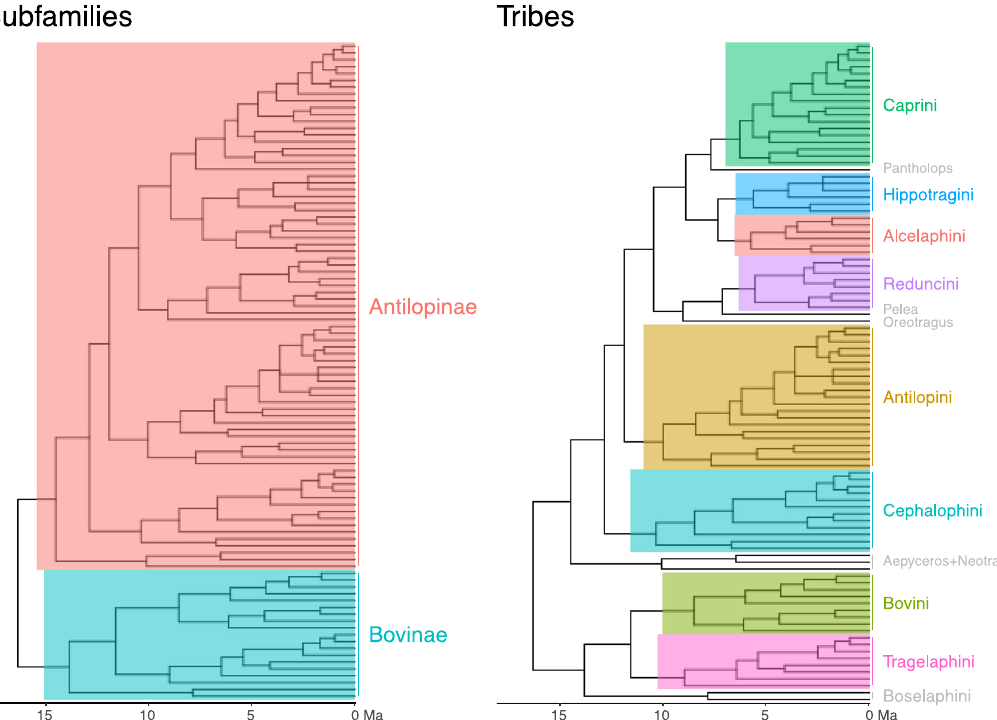
Fig. 1 Dated phylogeny of Bovidae with species used in this study. Subfamilies and tribes with more than three species are highlighted. Tree and ages are based on Faurby and Svenning 51